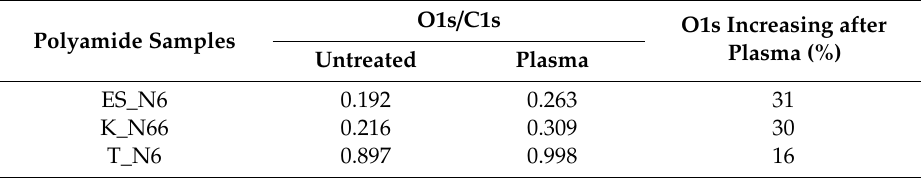
Table 2. XPS results of plasma-untreated and treated